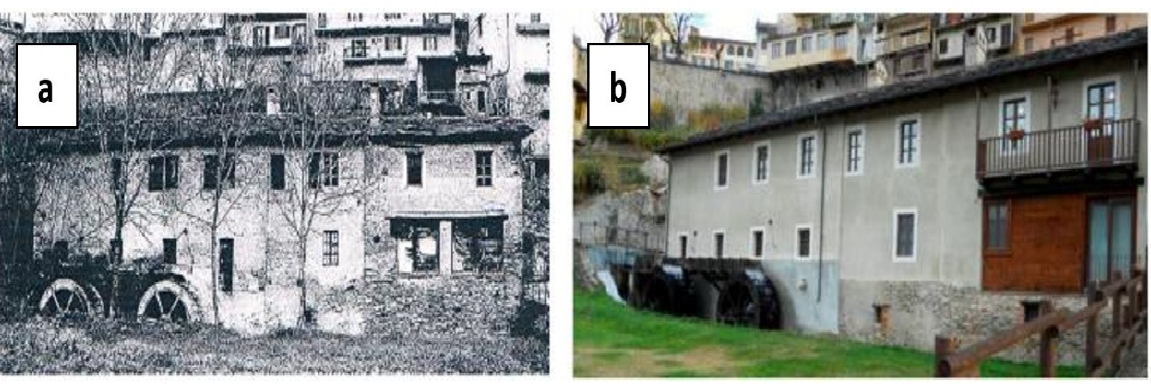
Figure 15. Riviera water mill: ( a ) before the renovation and ( b ) after the renovation (adapted from [40]).